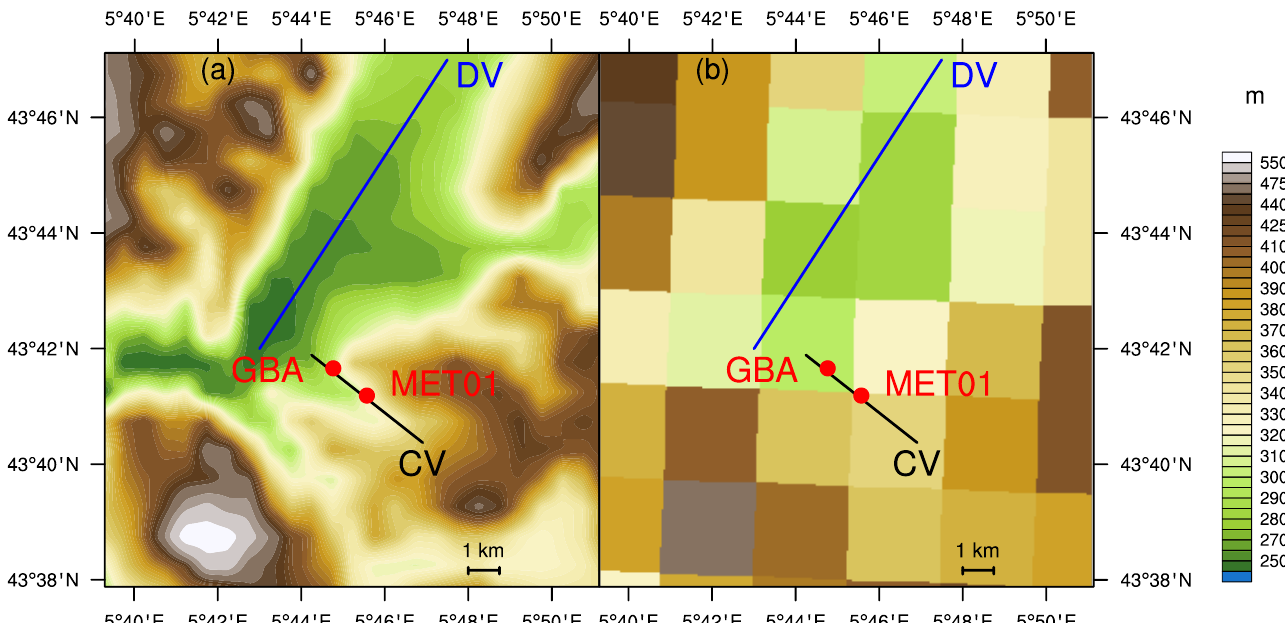
Figure 4. ( a ) Topography of the region of Cadarache with a 110 m horizontal resolution. The blue line identifies the main axis of the Durance valley (DV), the black line represents the Cadarache valley (CV) and the red dots represent the locations of the meteorological stations MET01 and GBA. ( b ) Topography of the same area as represented in WRF simulations with a 3 km horizontal